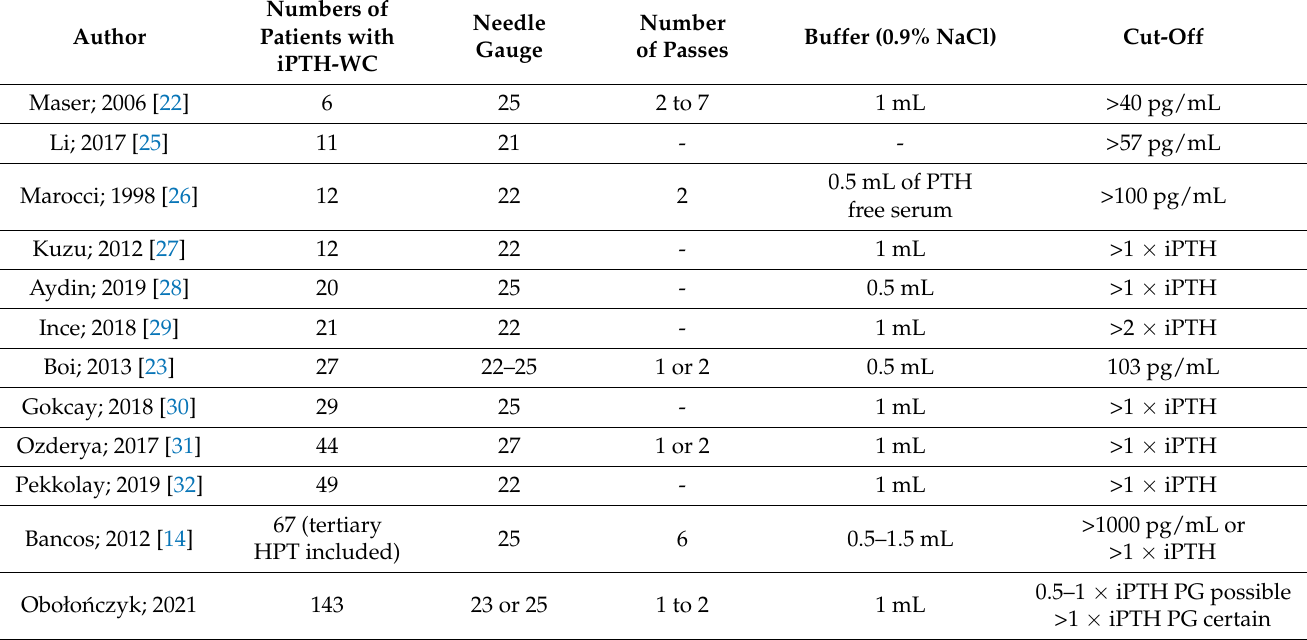
Table 5. Characteristics of selected studies (adapted from Castellana [24] and